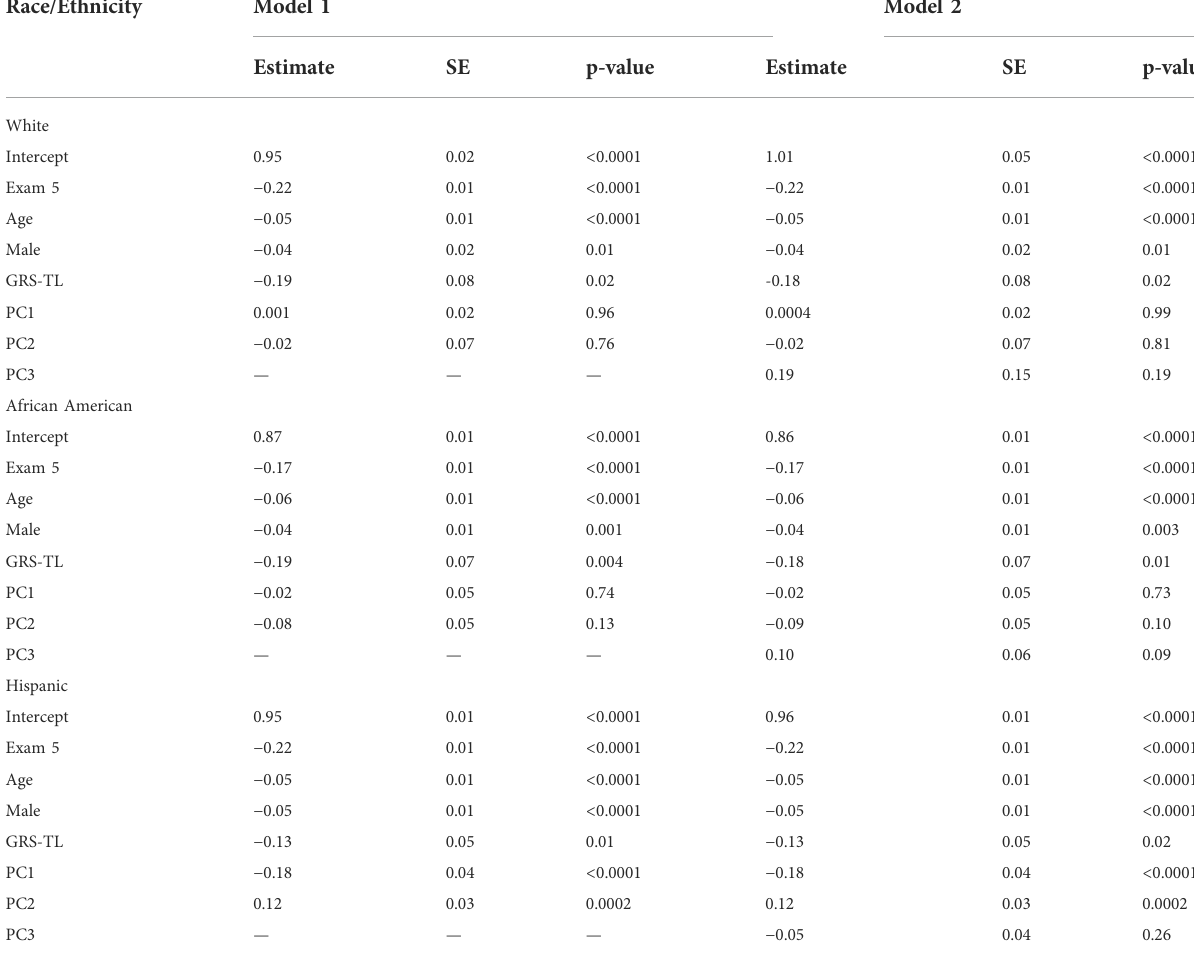
TABLE 4 Association between GRS-TL and TL (T/S ratio) by race/ethnicity.